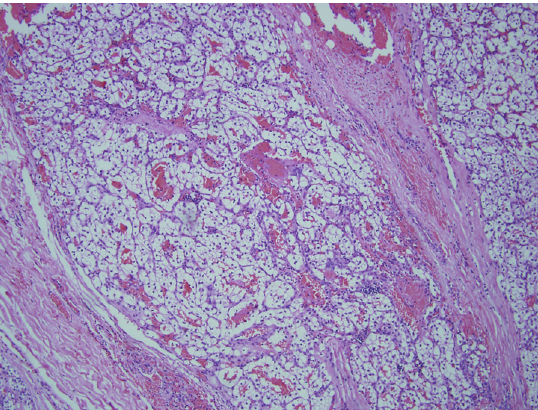
Figure 2: The tumor is characterized by sheets of round to polygonal cells interspersed with numerous thin-walled blood vessels (Hematoxylin-eosin, ×